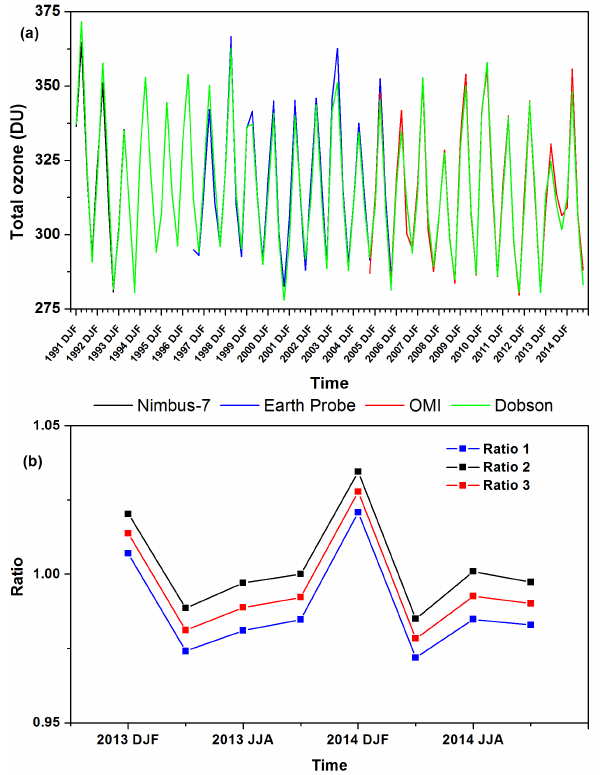
Figure 4. (a) Seasonal mean values of Dobson measurements along with satellite observations performed by Total Ozone Mapping Spectrometer (TOMS), on board Nimbus-7 and Earth Probe satel- lites, as well as Ozone Monitoring Instrument (OMI), on board Aura satellite, in Athens, Greece during 1991–2014. (b) The ratios of Dobson raw and corrected seasonal mean values to OMI seasonal mean values for the period 2013–2014. For details about the mean- ing of Ratio 1, Ratio 2 and Ratio 3 please see